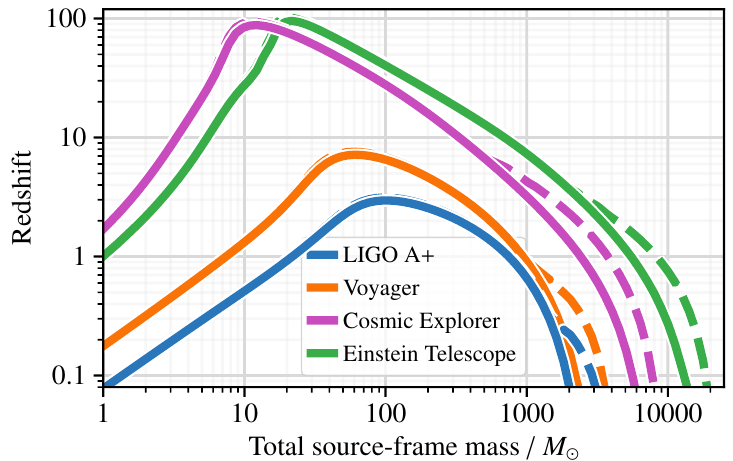
Figure 1. Detection capability of selected current and next-generation gravitational-wave interferom- eters. Each curve indicates the highest cosmological redshift at which an equal-mass, non-spinning compact binary coalescence could be detected with amplitude signal-to-noise ratio of 8, if the system is optimally oriented on the sky. Solid lines indicate detection using the gravitational radiation from the ( (cid:96) , m ) = ( 2,2 ) angular mode of the system only; dashed lines show the inclusion of higher-order angular modes using the simulated waveform family IMRP HENOM XHM [36].